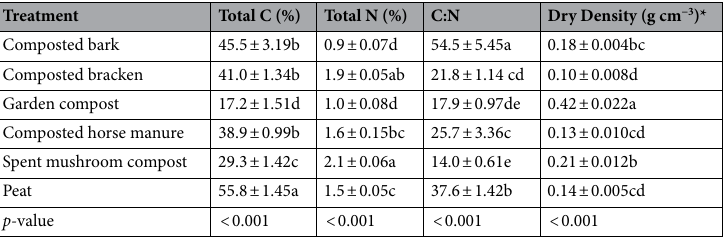
Table 1. Dry density and proportional C content of amendments applied. Mean of seven annual (Year 0–6) batches of amendments (n = 7); ± standard error. Treatments that share a subscript letter, for a particular variable, have no significant difference according to one-way ANOVA and Tukey’s post-hoc testing ( p > 0.05). *From Duddigan et al. 30 .